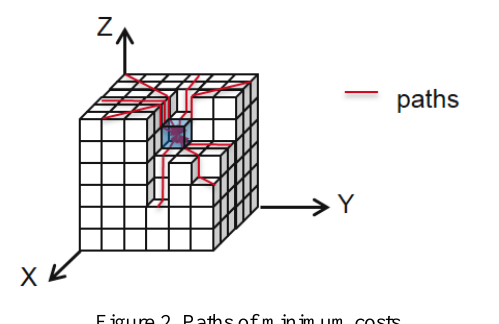
Figure 4. Limitation of search ranges